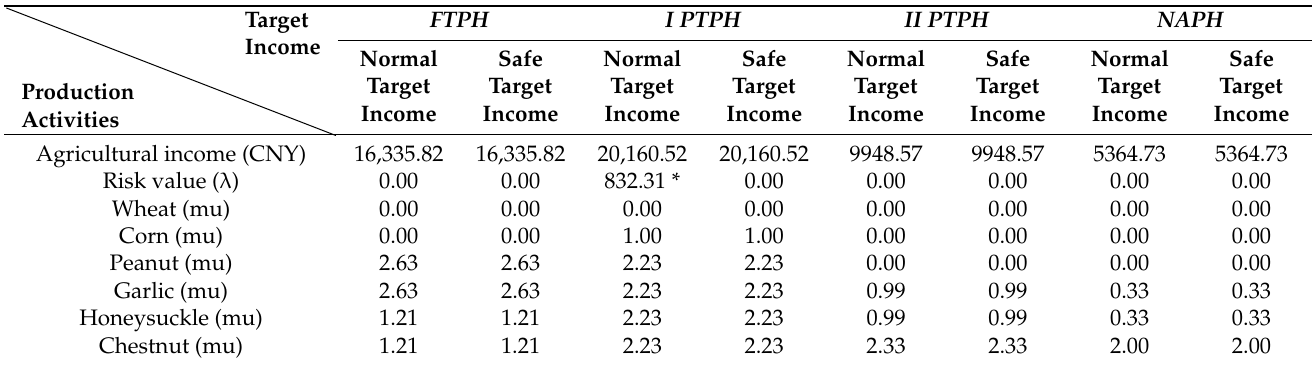
Table 5. The optimal agricultural incomes and production combinations for different types of peasant